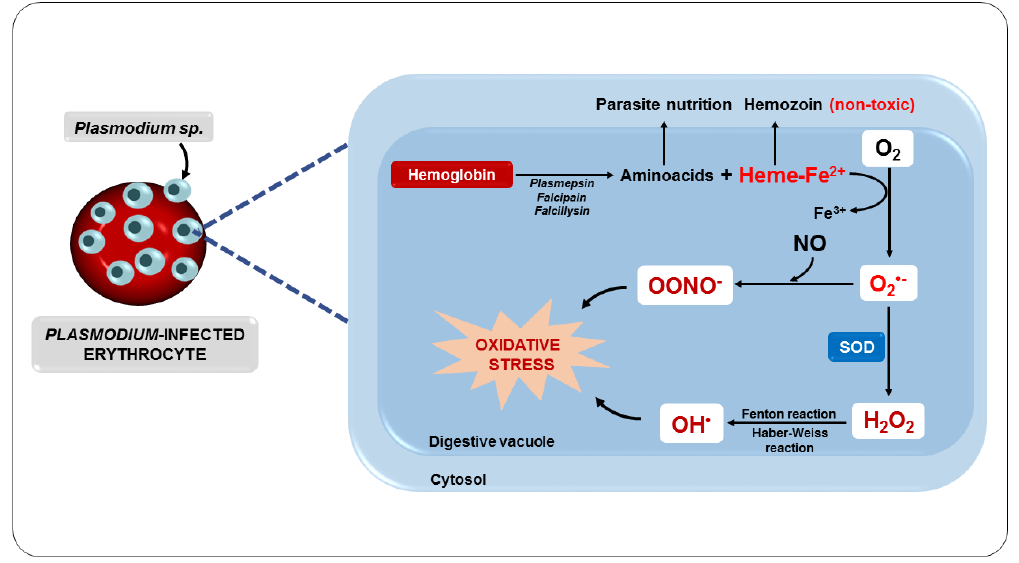
Figure 4. Oxidative stress as a consequence of parasite metabolism.